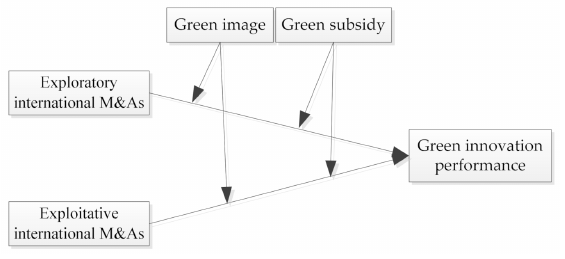
Figure 1. Theoretical